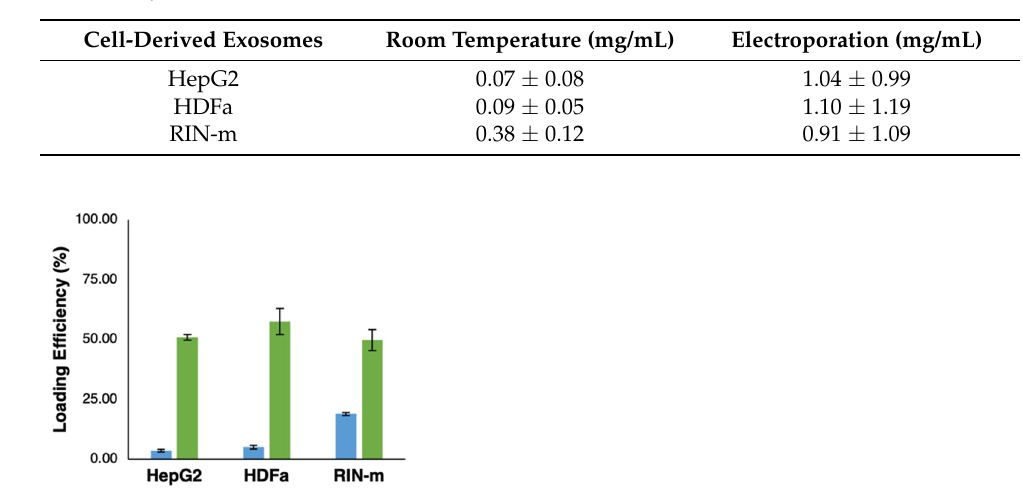
Figure 3. Loading efficiency of FITC–insulin (2 mg/mL) in HepG2-, HDFa- and RIN-m -derived exosomes. The graph shows the loading efficiency obtained with the incubation for 1 h at room temperature (RT) treatment (blue bars) and the electroporation at 200 V and 50 μF treatment (green bars).